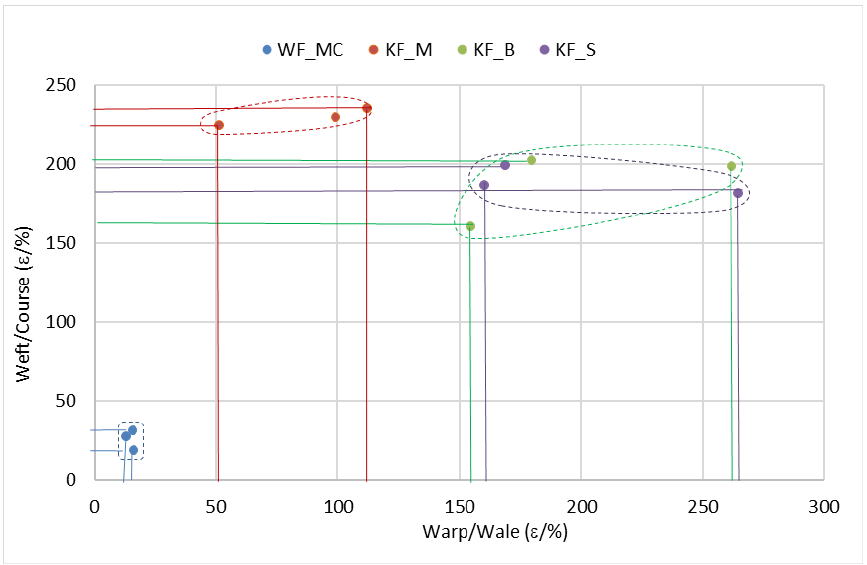
Figure 8. Relations of the breaking elongation in the warp/wale and weft/course direction for each sample.